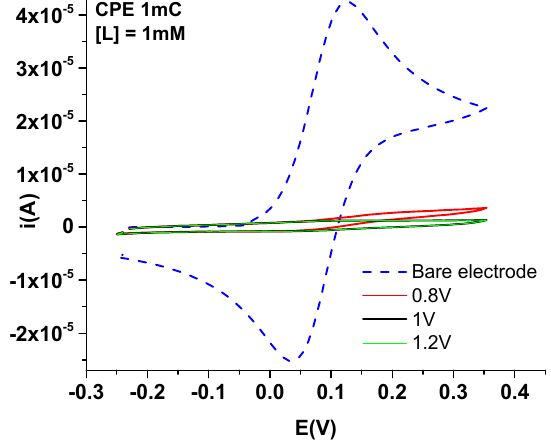
( b ) Figure 9. CV (0.1 V/s) curves in ferrocene solution (1 mM in 0.1M TBAP/CH 3 CN) of poly L ‐ modified electrodes prepared by CPE at +0.8 V in L solution (1 mM) in 0.1 M TBAP/CH 3 CN using different electropolymerization charges ( a ) and dependence of the of peak area on ferrocene (calculated by the integration of the CV curve 1st cycle between − 0.25 V and +0.35 V) on the polymerization charge ( b ). 3.4. Characterization of Poly L ‐ Modified Electrode Surfaces Poly L modified electrodes were investigated by AFM and SEM to compare the morphologies of the poly L films obtained in different conditions. Poly L films were prepared by CPE using the same electropolymerization charge per cm 2 . This charge corresponds to that which was used in the